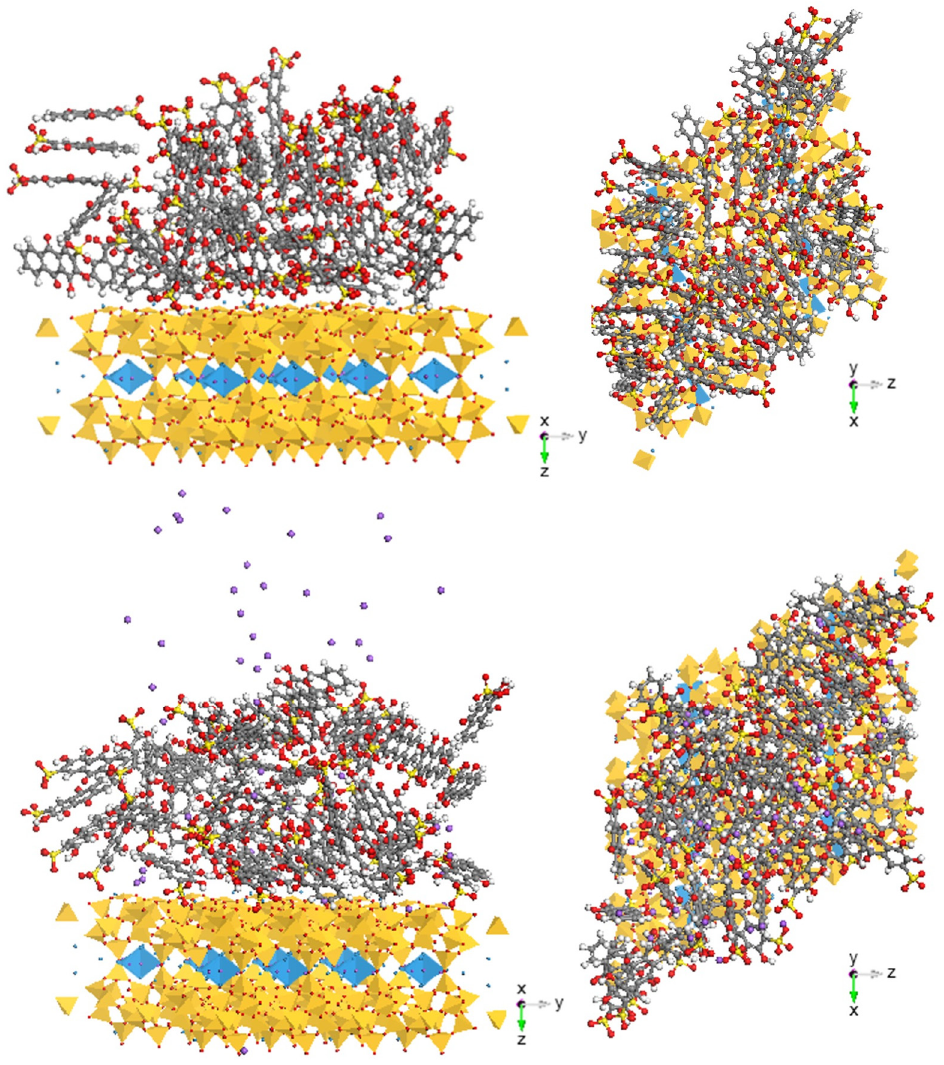
Figure 7. Molecular dynamic simulation showing ARS uptake in the absence ( top ) and presence ( bottom ) of counterion Na + on the ac plane of zeolite projected along a ( left ) and b ( right ) directions. For ARS: red: O; yellow: S; grey: C; white: H; purple: Na + .